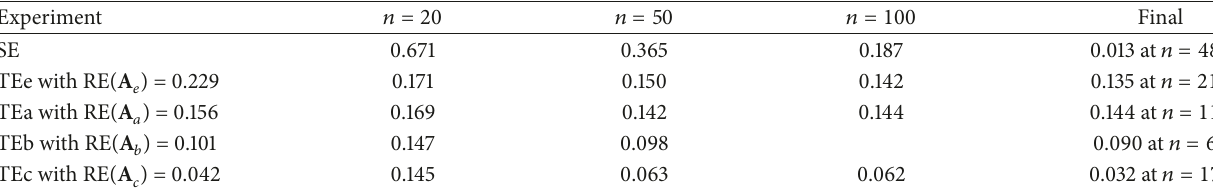
Table 1: Entire-domain averaged RMS errors (in ms −1 ) for the analysis increments obtained from SE, TEe, TEa, TEb, and TEc applied to the first set of innovations with periodic extension and consecutively increased 𝑛 , where 𝑛 is the number of iterations. All the RMS errors are evaluated with respect to the benchmark analysis increment. The relative error (RE) of the estimated analysis error covariance for updating the background error covariance in the second step of the two-step analysis is listed with the experiment name in the first column for each two-step experiment.